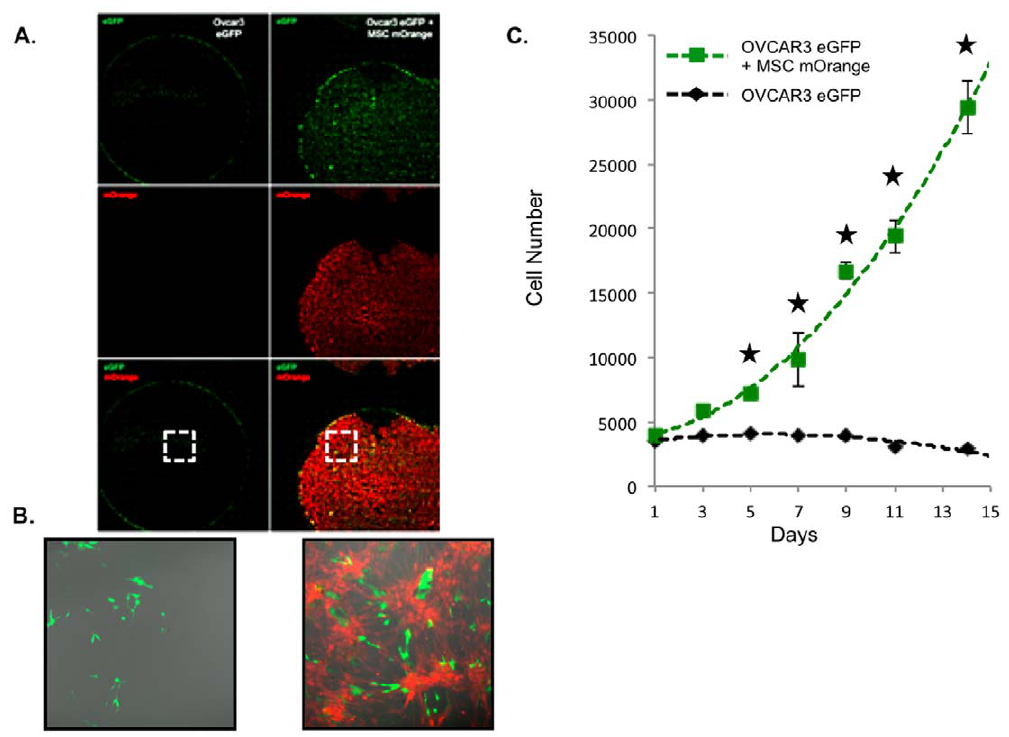
Figure 3. MC sustains OCC proliferation in a serum free cytokine free context. A. OCC were cultivated on a MC expressing mOrange or direclty on the plastic dish. Proliferation assay was carried out in a serum free-cytokine free media. Pictures were taken every two days, and GFP cells were quantified. B. Detail of the well on day 14, we can notice OCC display a normal morphology. C. Chart displaying cell count carried over 14 days. OVCAR3 eGFP when seeded on a MC are able to sustain cell cycle in a serum free cytokine free media. Similar results were obtained with SKOV3 (data not shown). SEM are represented, n=3, | p , 0.05 t-Student Test.